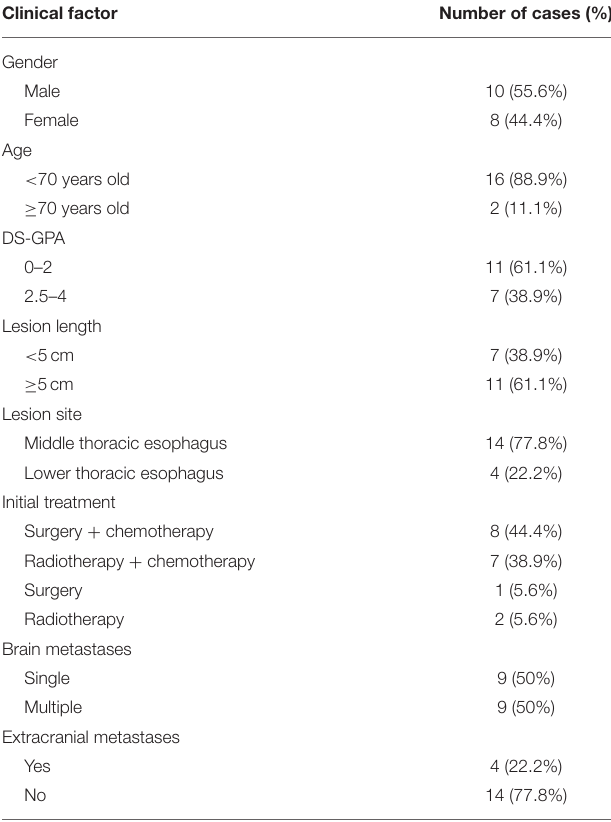
TABLE 1 | Characteristics of patients. Clinical